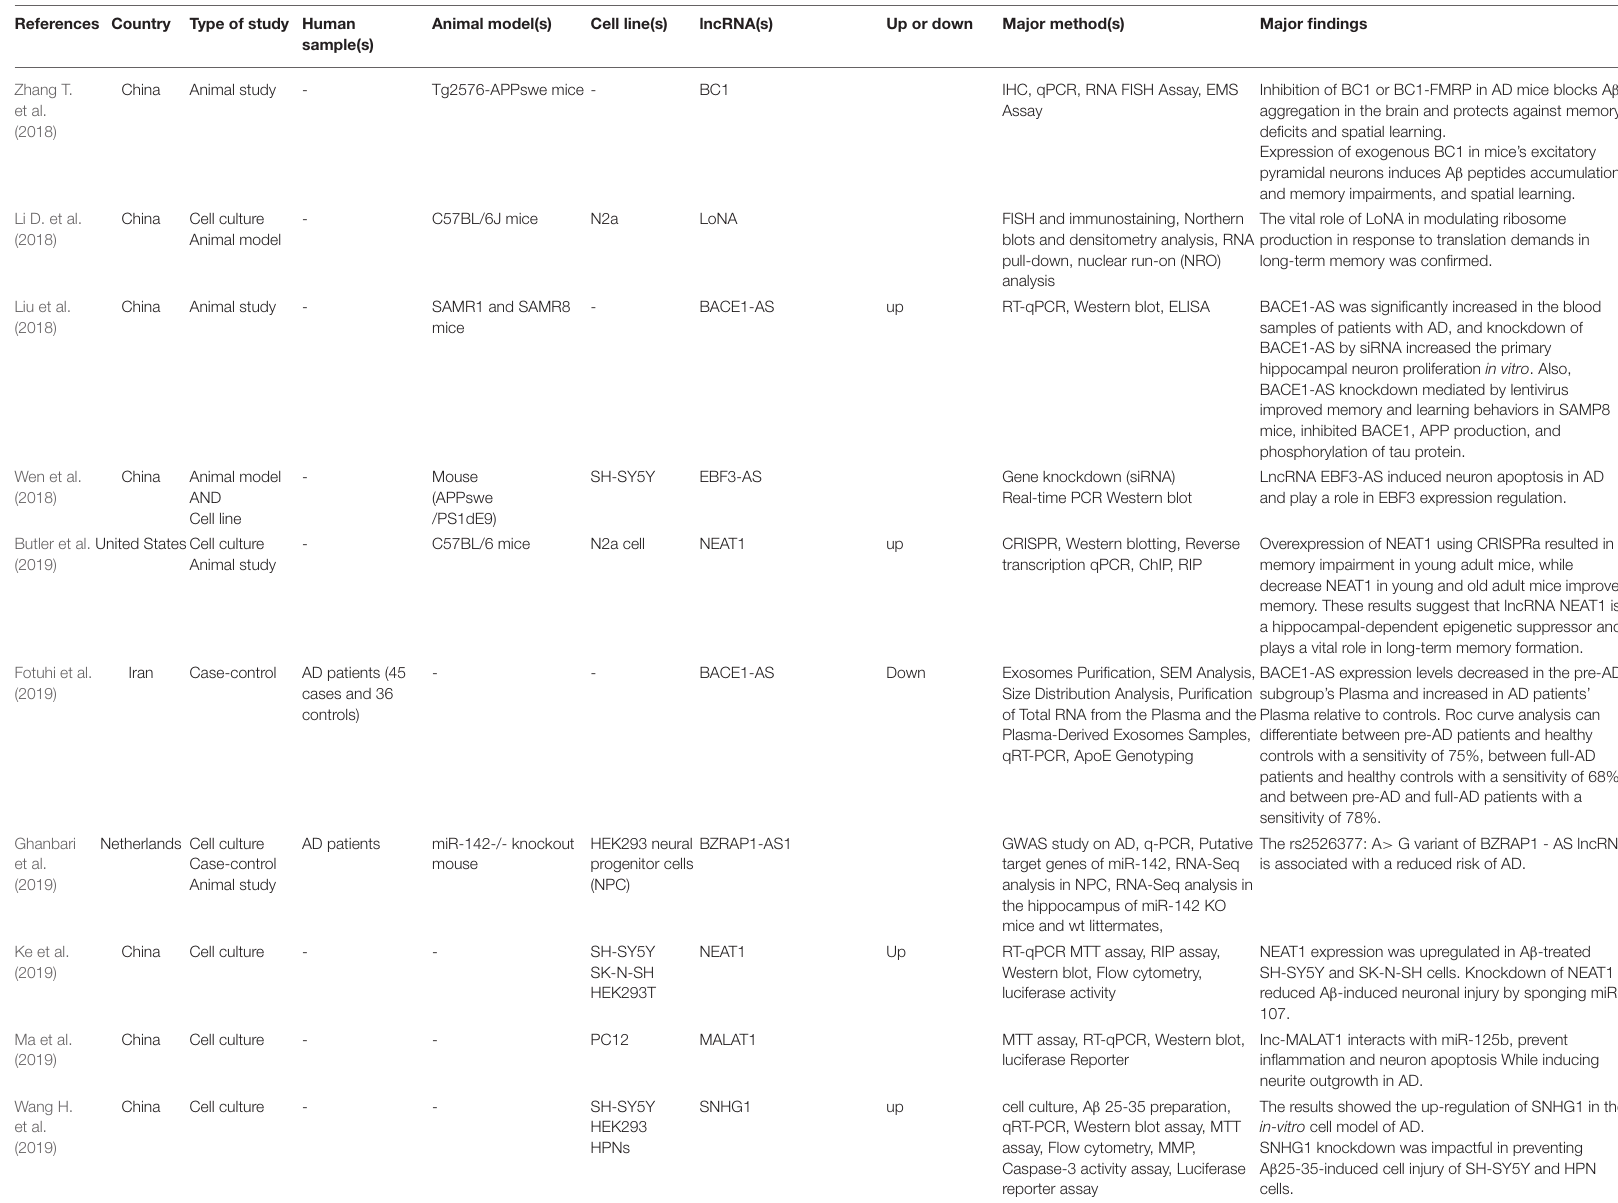
neurite outgrowth in AD. The results showed the up-regulation of SNHG1 in the in-vitro cell model of AD.